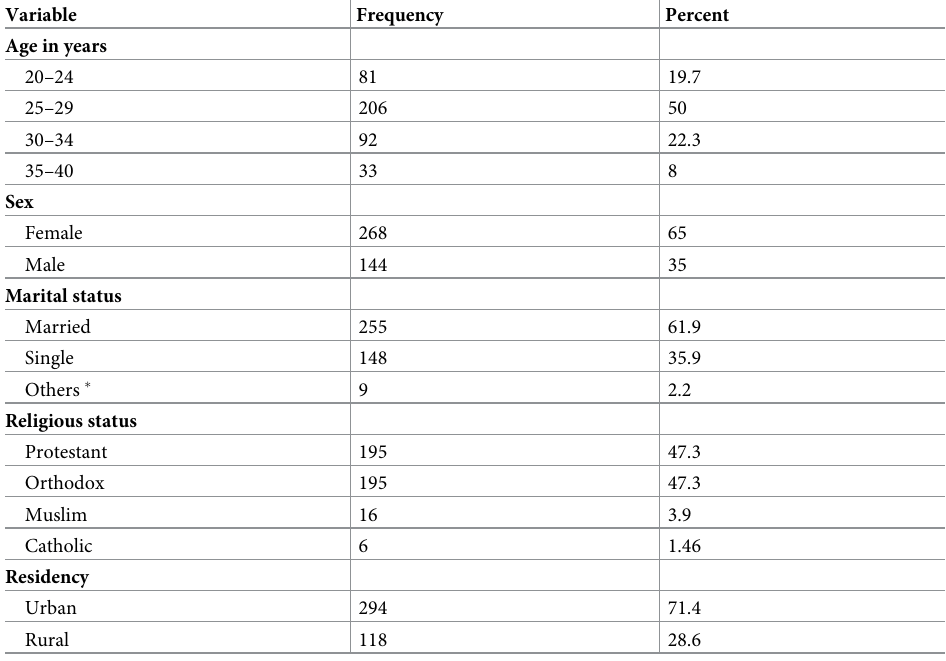
Table 1. Socio-demographic characteristics of obstetric care providers who participated in the study and were working in public health facilities of southern Ethiopia, 2020 (N =